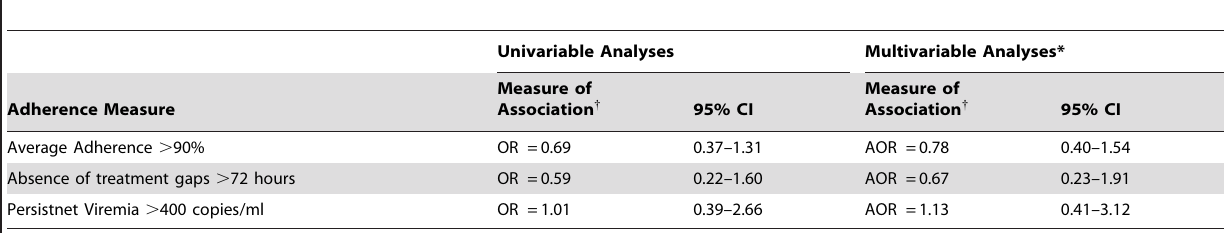
Table 2. Univariable and multivariable models for association between completion of pre-therapy adherence counseling and measures of medication adherence and persistent viremia during the first three months of ARVs in a cohort of HIV-positive patients in rural